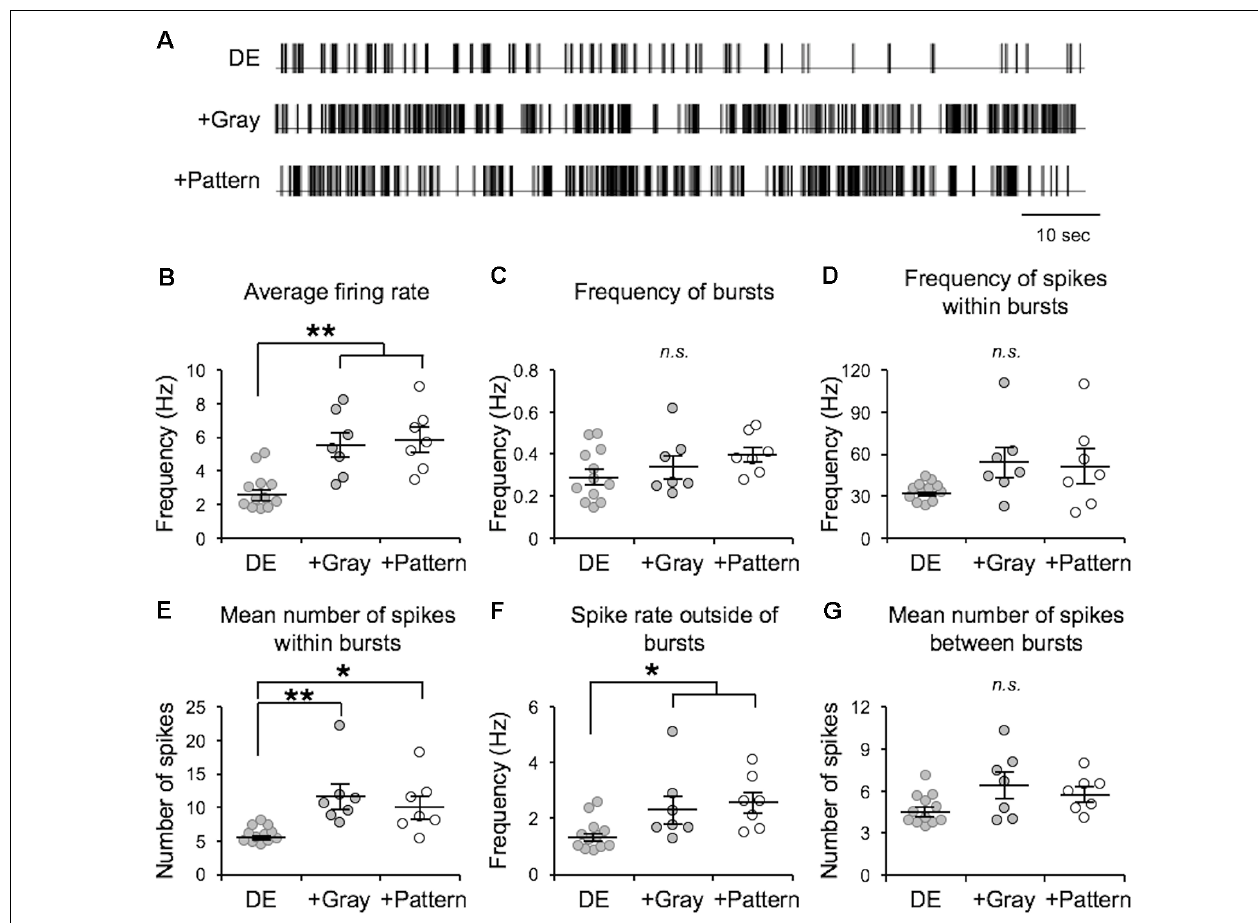
FIGURE 1 | Analysis of visual experience-dependent in vivo spike activity. Single unit recordings were acquired in primary visual cortex (V1) layer 4 (L4) of awake head-fixed dark exposed (DE) mice facing a blank screen in a dark room (DE), DE mice placed in a lighted room facing a gray screen (+Gray), and DE mice placed in a lighted room facing a screen with a grating (+Pattern). See “Materials and Methods” section for details. (A) Example inter-spike-interval trains recorded from DE (top), +Gray (middle), and +Pattern (bottom) conditions. Each vertical line represents an action potential. (B) Average overall firing rate was significantly elevated in the two groups receiving visual stimuli (DE = 2.74 ± 0.32 Hz; DE+Gray = 5.52 ± 0.73 Hz; DE+Pattern = 5.82 ± 0.70 Hz; ANOVA, F = 1.341, p = 0.0004; Newman–Keuls multiple comparison ** p < 0.01). (C) There was no significant difference in the frequency of bursts (see “Materials and Methods” section for quantification of bursts) across groups (DE = 0.295 ± 0.036 Hz; DE+Gray = 0.341 ± 0.054 Hz; DE+Pattern = 0.397 ± 0.037 Hz; ANOVA, F = 1.511, p = 0.2417). n.s.: not statistically significant. (D) There was an increase in the average frequency of spikes within a burst in the two groups receiving visual stimuli, which did not reach statistical significance (DE = 33.17 ± 1.86 Hz; DE+Gray = 54.28 ± 10.56 Hz; DE+Pattern = 51.30 ± 11.75 Hz; ANOVA, F = 2.647, p = 0.0923). This was due to a large increase in variance (Bartlett’s test for standard deviations, Bartlett’s statistic = 18.4, p = 0.0001). (E) The mean number of spikes within a burst was significantly increased in the visual stimuli groups (DE = 5.82 ± 0.34; DE+Gray = 11.61 ± 1.82; DE+Pattern = 10.12 ± 1.60; ANOVA, F = 7.575, p = 0.0030; Newman–Keuls multiple comparison * p < 0.05, ** p < 0.01). (F) There was a significant increase in the frequency of spikes outside of bursts in the two visual